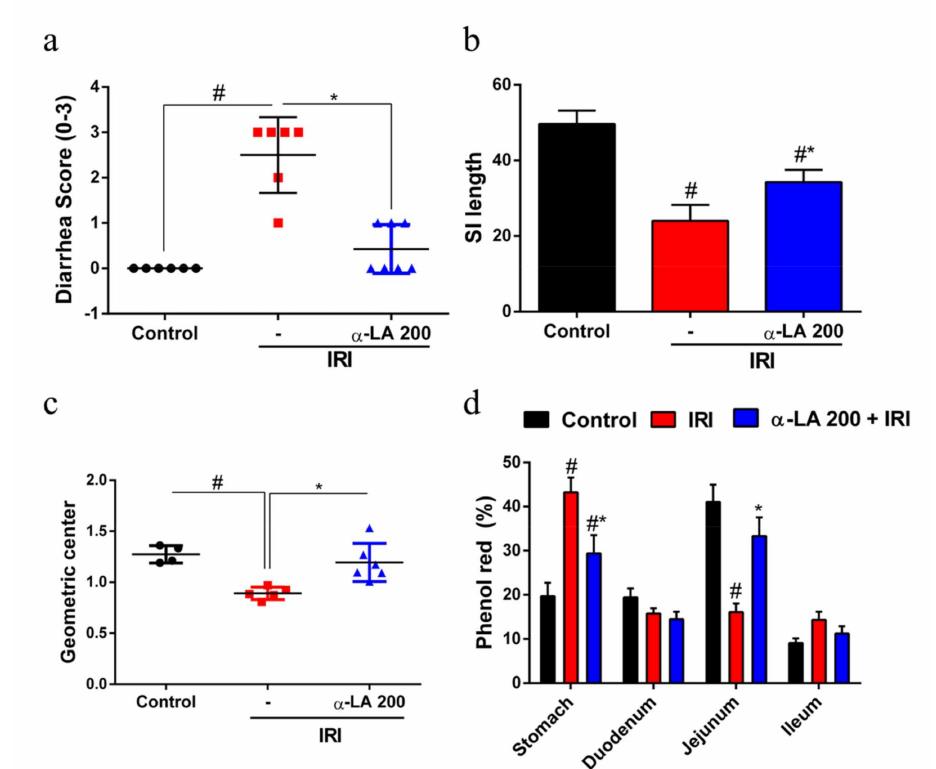
Figure 4. α -LA treatment prevents irinotecan-induced diarrhea and intestinal dysmotility in mice. ( a ) Diarrhea score on day 7 of the experimental protocol (0, normal; 1, slight; 2, moderate; 3, severe diarrhea). The results are expressed as the mean ± SEM ( n = 6 per group). ( b ) Bars represent the mean ± SEM of the small intestine (SI) length ( n = 6 per group). ( c ) and ( d ) indicate the relative distribution (geometric center) and percentage of phenol red in stomach and small intestine segments of mice with irinotecan-induced intestinal mucositis that received α -LA pretreatment or no pretreatment. The results are expressed as the mean ± SEM ( n = 6 per group). # represents p < 0.05 versus the control group, and * indicates p < 0.05 versus the IRI group. One-way ANOVA followed by Bonferroni’s